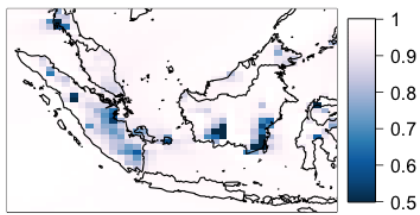
Figure 10. The ratio of the changes in ozone concentrations in the Modern Palm scenario compared to the changes in ozone in the BVOC-only simulation. Regions less than 1 show where increasing deposition velocities over palm plantations counteract some of the ozone increases driven by increasing isoprene emissions.